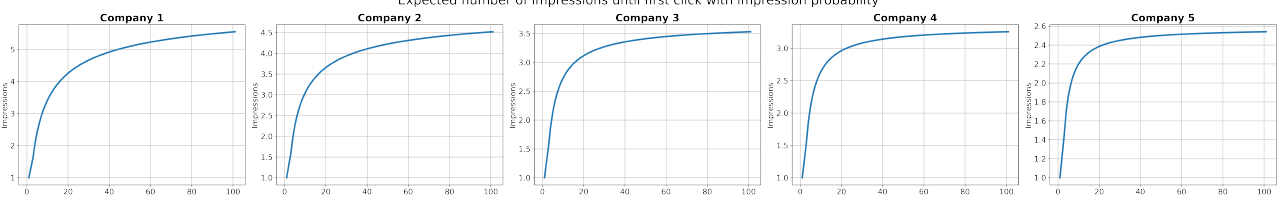
Figure 9. The figure shows the number of expected impression for each client and FC under the assumption of a distributed chances of getting new